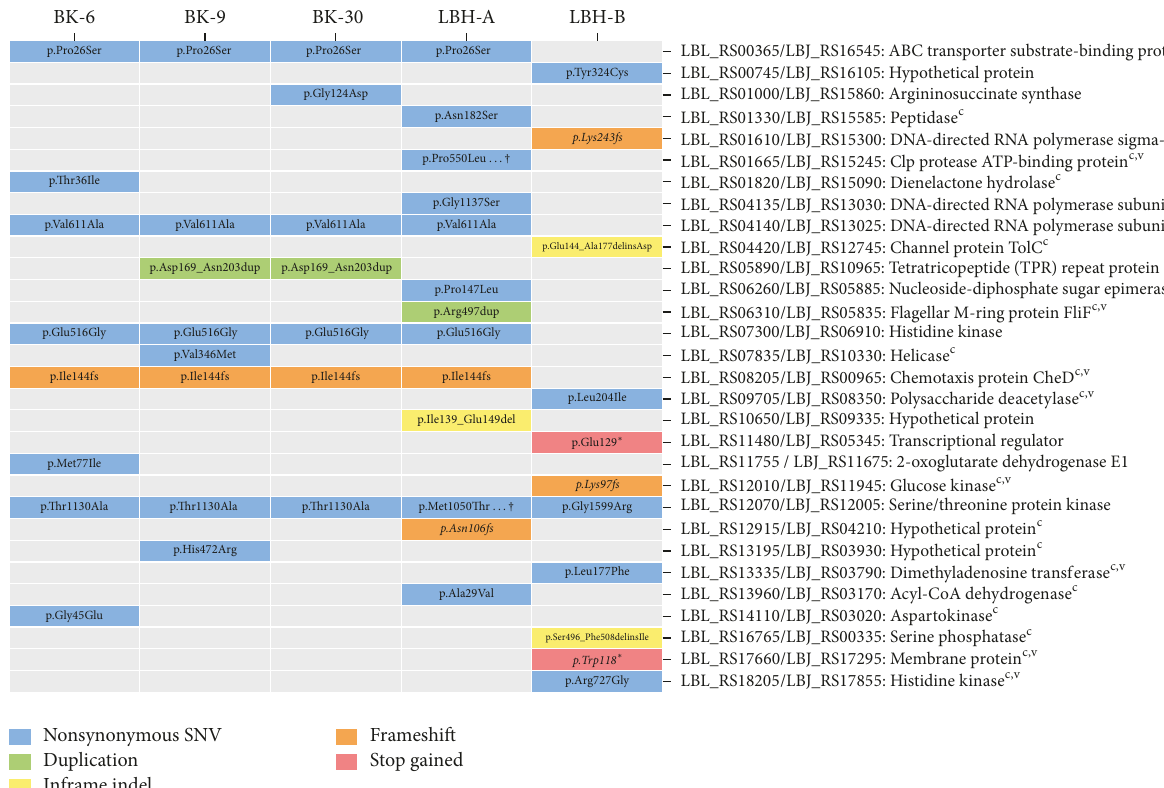
Figure 2: Reference genes with at least one variant of moderate to high predicted impact in our sequenced specimens of the corresponding subtypes . Core genes are indicated by a (c) and genes with similarity to previously reported virulence factors are indicated with a (v). Variants that putatively generated a pseudogene in the genome of the corresponding specimen are italic. Variants are labelled by using the protein (p.) part of the HGVS nomenclature (http://www.hgvs.org/mutnomen/). In this notation, “del” means deletion, “ins” means insertion, “dup” means duplication, “fs” means frameshift, and “ ∗ ” indicates a stop codon gained. † indicates that the corresponding gene has more than one mutation; see Table S3 for the full list of